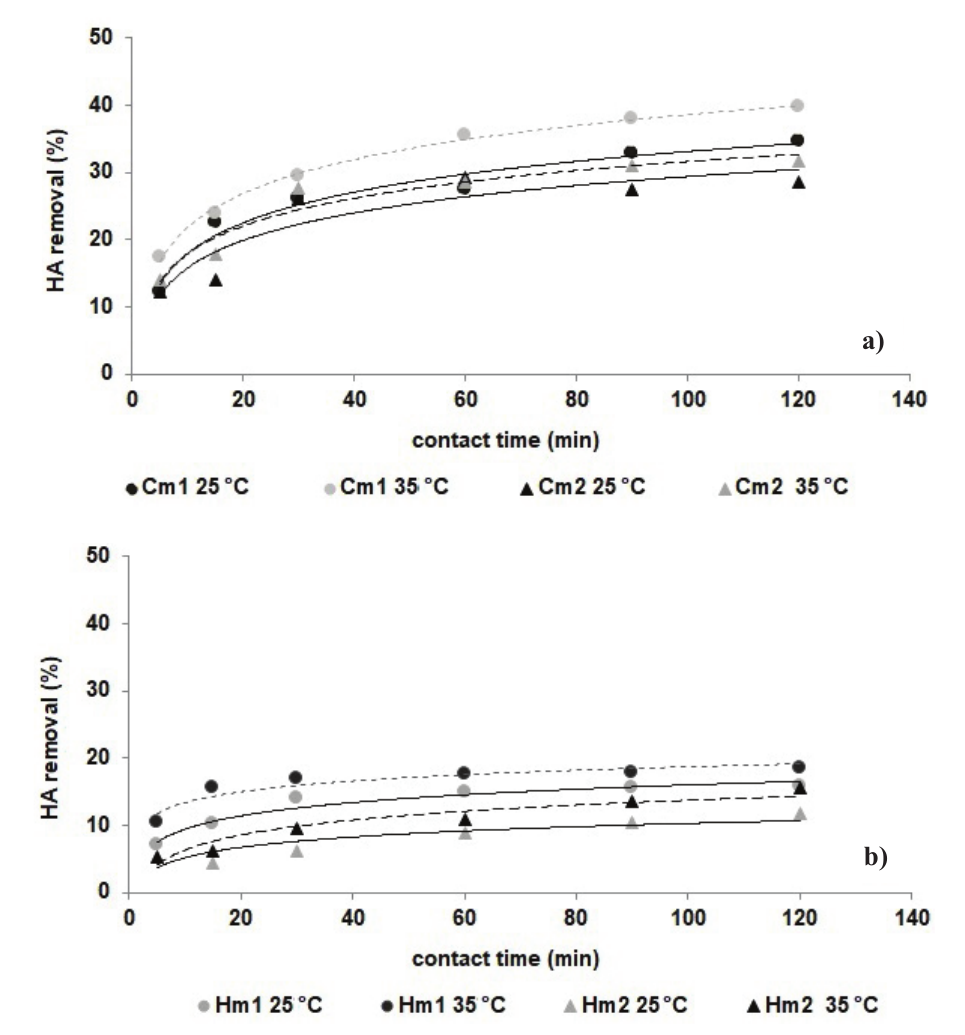
Fig. 6 – Effects of contact time on HA removal by (a) Cm1 and Cm2, and (b) Hm1 and Hm2 (γ = 5 mg L –1 , γ = 1 g L –1 , T = 25 °C and 35 °C, V HA ads